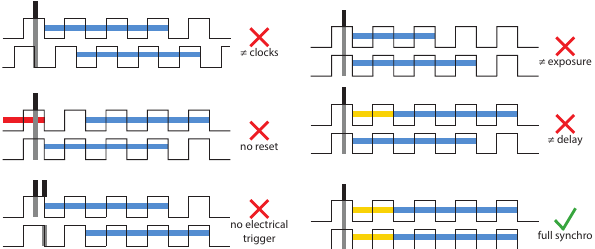
Figure 4: Different synchronization schemes. A full synchro- nization requires a trigger, a clock, a delay and an acquisition synchronizations.